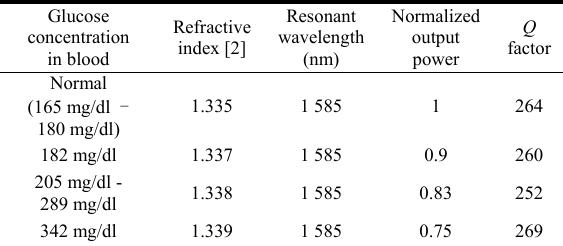
Table 3 Glucose concentration in blood and its refractive index, resonant wavelength, normalized output power, and Q factor of the proposed sensor.